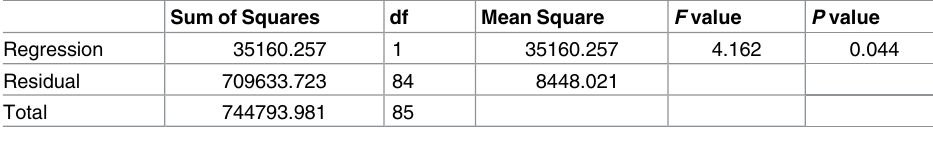
Table 5. Linear regression results for the effect of the size of the intimal entry on BF.